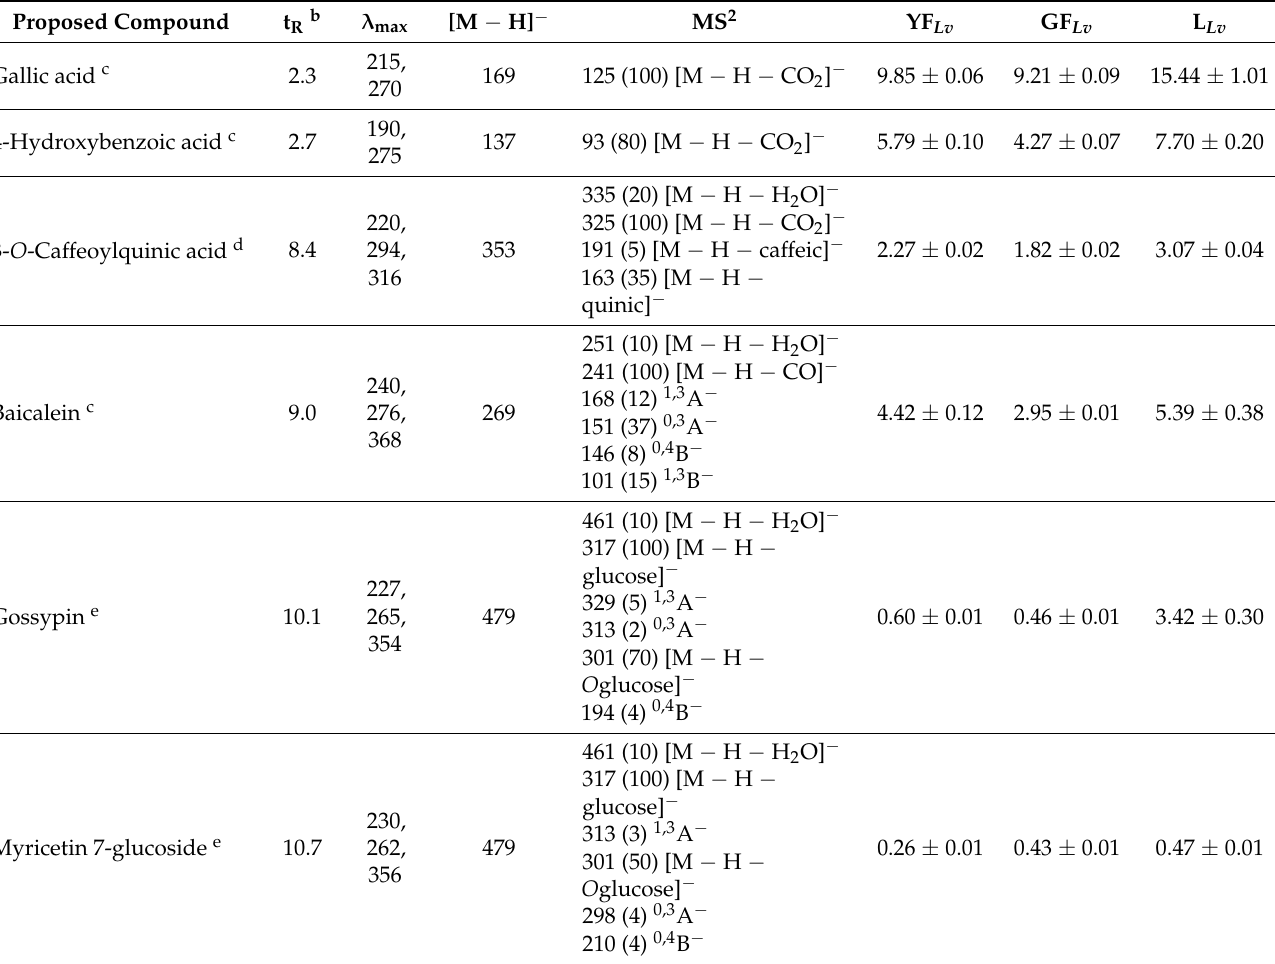
Table 2. Chemical composition of L. vulgare ethanolic extracts. Retention time (t R ; min),